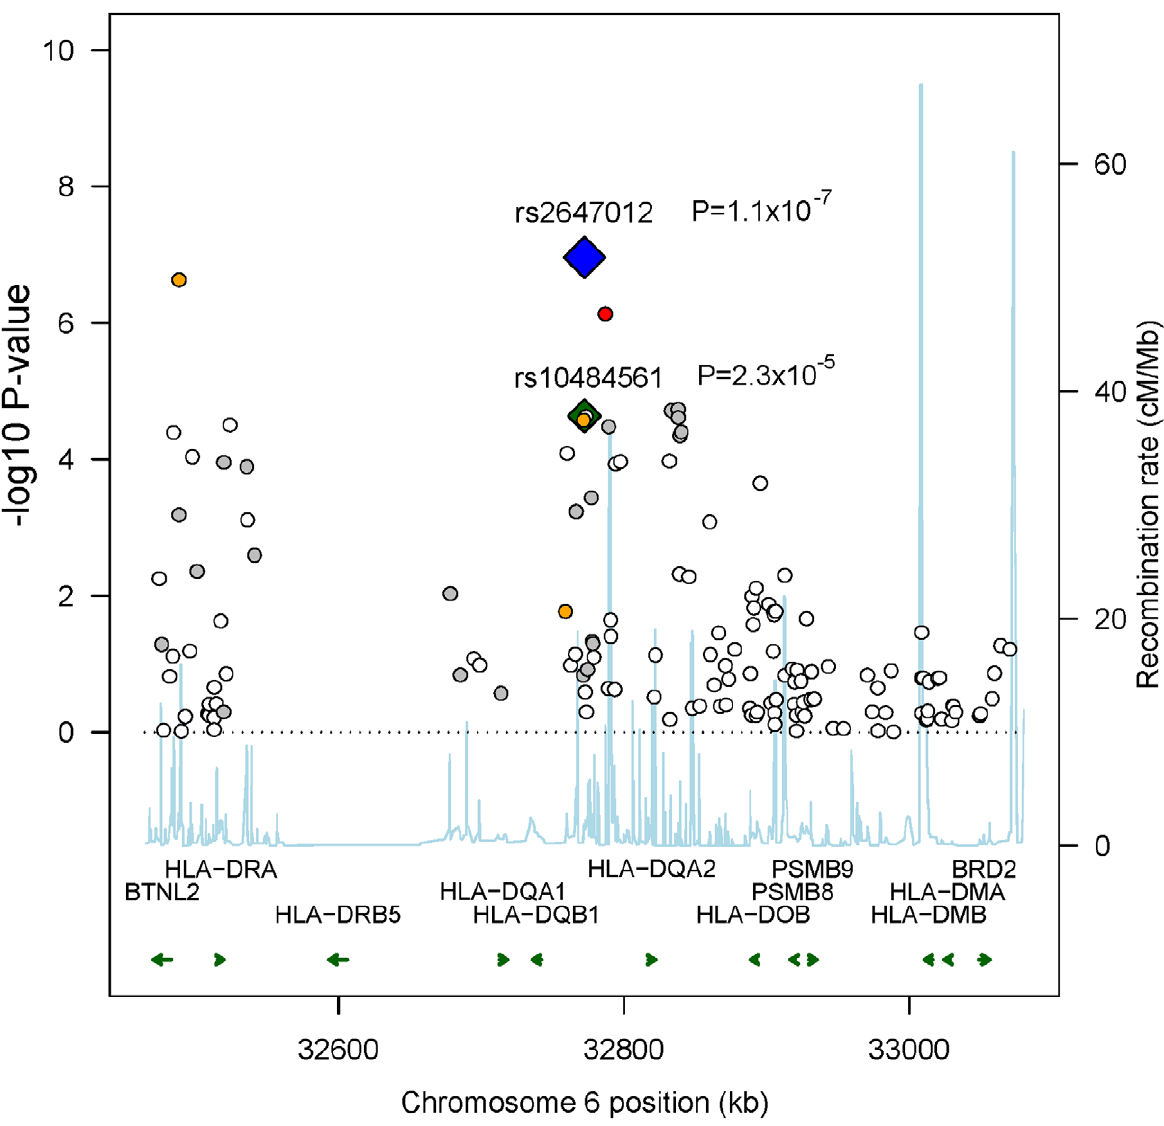
Figure 2. Recombination plot showing associations in 6p21.32 in Stage 1. Plot showing the pattern of associations in Stage 1, the recombination rate (build 36, HapMap CEU) and genes located in the region. The two SNPs showing independent association and their respective P-values are labeled (blue: rs2647012, green: rs10484561); other SNPs are color-coded according to their LD with rs2647012 (red r 2 . 0.8, orange 0.5–0.8, grey 0.2–0.5, white ,